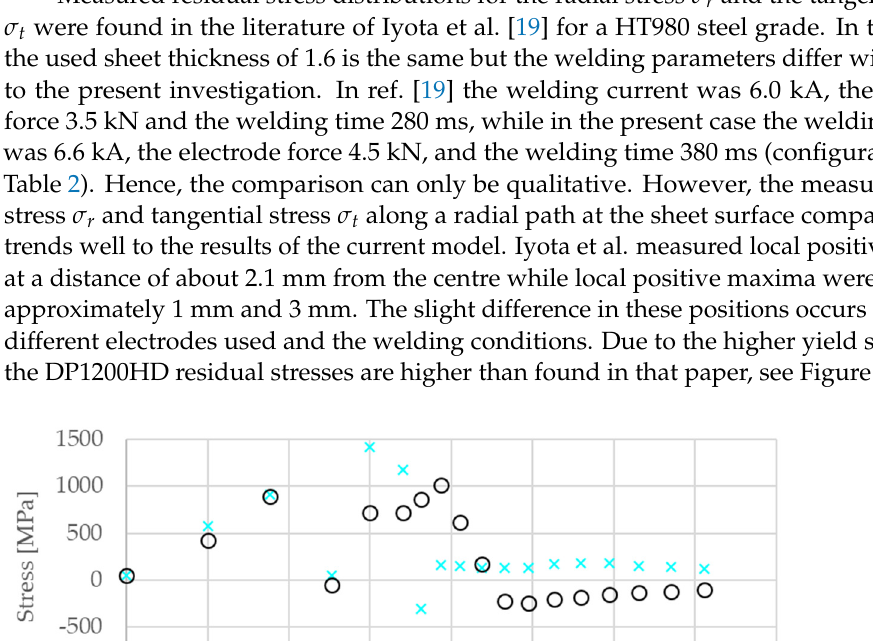
Figure 10. Simulation results for the conditions after rapid cooling compared to residual stresses in radial (s_rad XRD) and tangential direction (s_tan XRD) of XRD measurements in the sheet depth for the centre of the weld. Note that the calculated radial s_rad model and tangential s_tan model stress distribution overlap. Due to the good overall correlation the model can be rated as validated. The model might be further applied to increase the understanding of the evolution of local quantities during RSW and it can be used for RSW process design. This is especially interesting for minimizing effects such as LME by means of improved process parameters and electrode geometries. For further improvement of the simulation results it would be necessary to determine the electrical properties of the steel sheets over a large temperature range for this steel grade. 4. Conclusions A large amount of material data describing the electrical, thermal, metallurgical, and mechanical properties of the advanced high strength dual phase steel DP1200HD necessary for simulating RSW processes was collected in lab scale material tests. These data served as input for a multi-physical FE-model. At the same time, a large number of